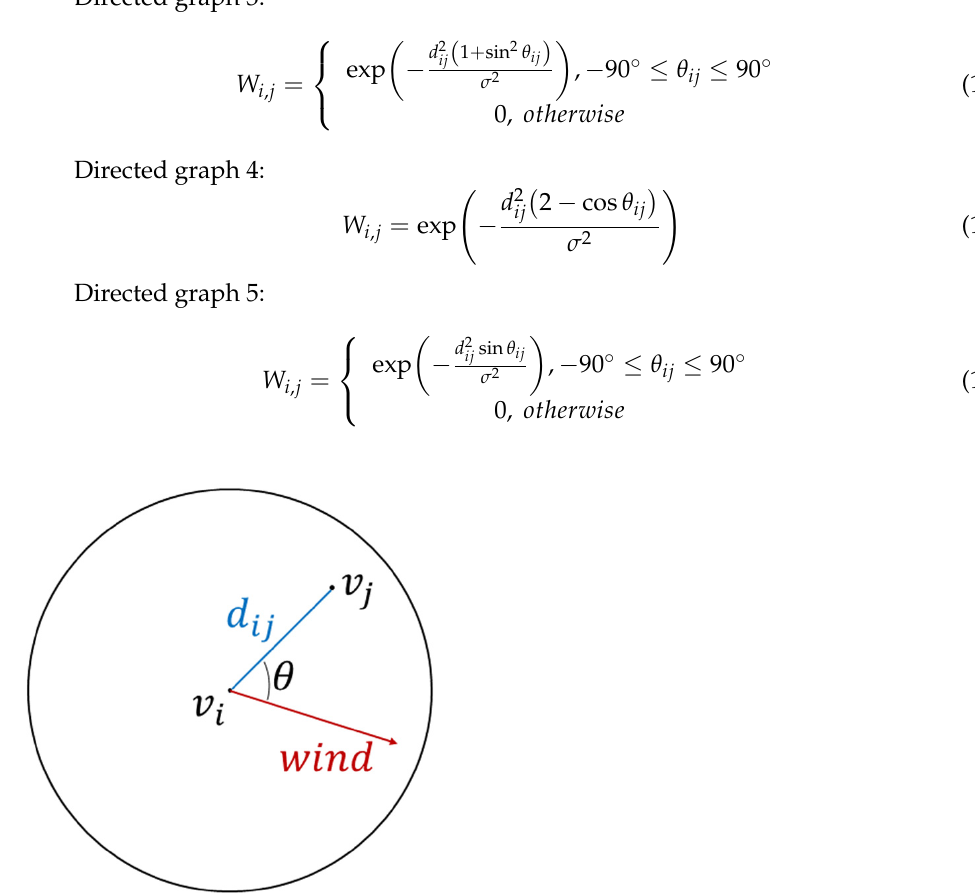
Figure 3. Spatial relationship between wind direction and directed graph construction. Wind vector shows the vector weighted average wind direction of each data group (i.e., Winter and Spring, Summer and Autumn).